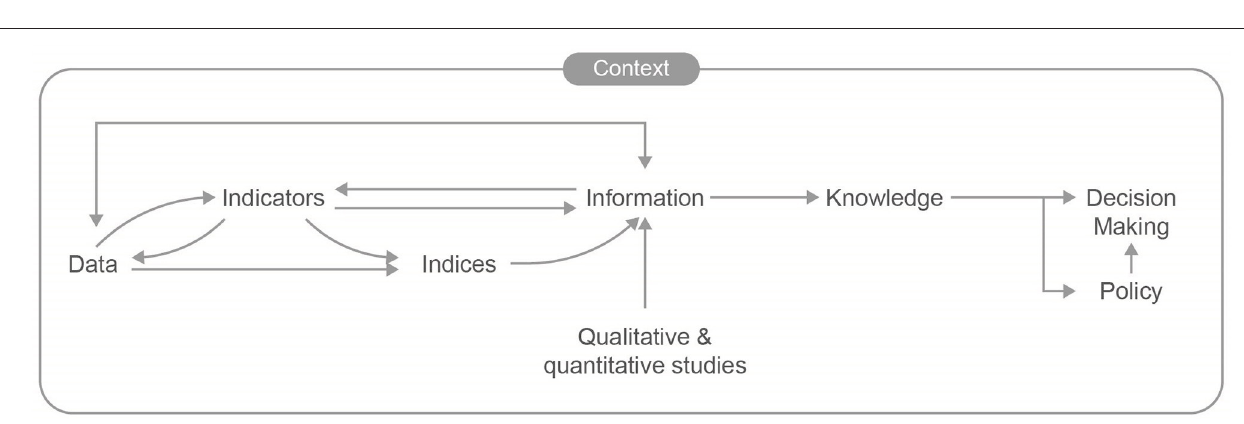
linkages between the constituent sectors, i.e., “nexus” indicators that measure water for energy, water for food, energy for water, etc. Where these “nexus” or “integrated” indicators do exist, they are invariably reported by too few countries to form part of